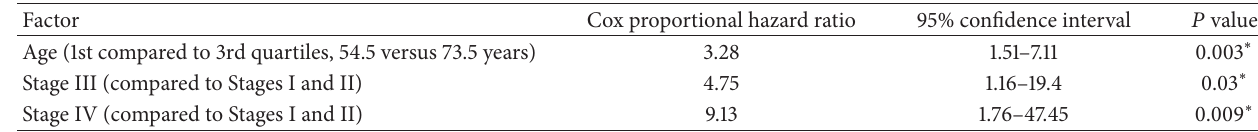
Table 2: Hazard ratios for death by age and stage. Univariable and Cox proportional hazard ratios demonstrating the association between advanced age and stage with an increased risk of death.